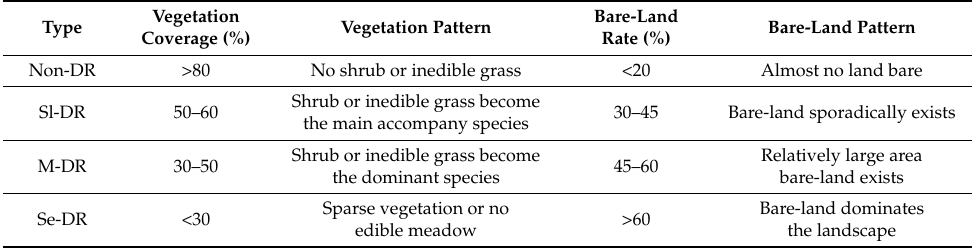
Table 2. Remote sensing derived system of rangeland degradation in the study region. Non-DR, non-degraded rangeland; Sl-DR, slightly degraded rangeland; M-DR, moderately degraded rangeland; and Se-DR, severely degraded